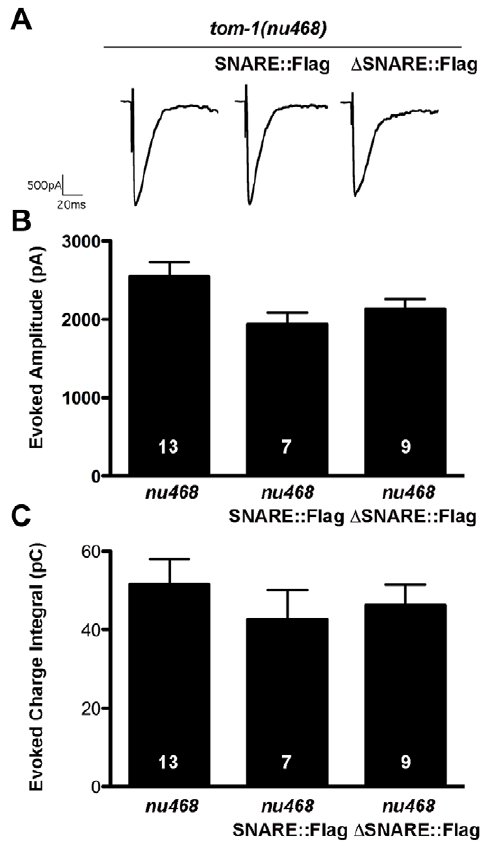
Figure 3. Both TOM1-A SNARE and D SNARE are stably expressed and localized at synapses. A. The FLAG tagged SNARE and D SNARE constructs are of the predicted size on Westerns. B. Representative confocal images of SNARE::FLAG and D SNARE::FLAG expression in the ventral nerve cord (VNC) anterior to the vulva, the region used for electrophysiological recording. Staining in the lateral nerve cord (LNC) was also observed. Scale bar is 50 m m. doi:10.1371/journal.pone.0026185.g003 PLoS ONE |